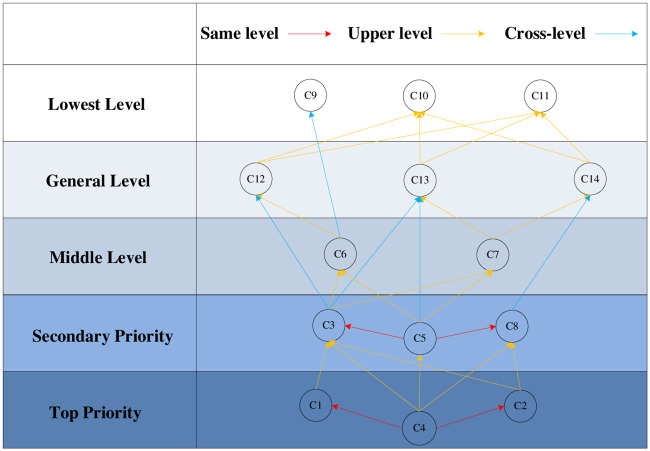
ISM model structure.